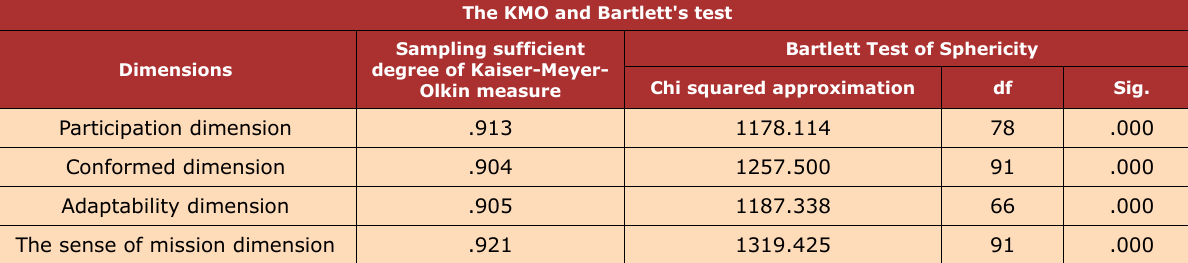
Table 4. The dimensions of KMO and Bartlett's test